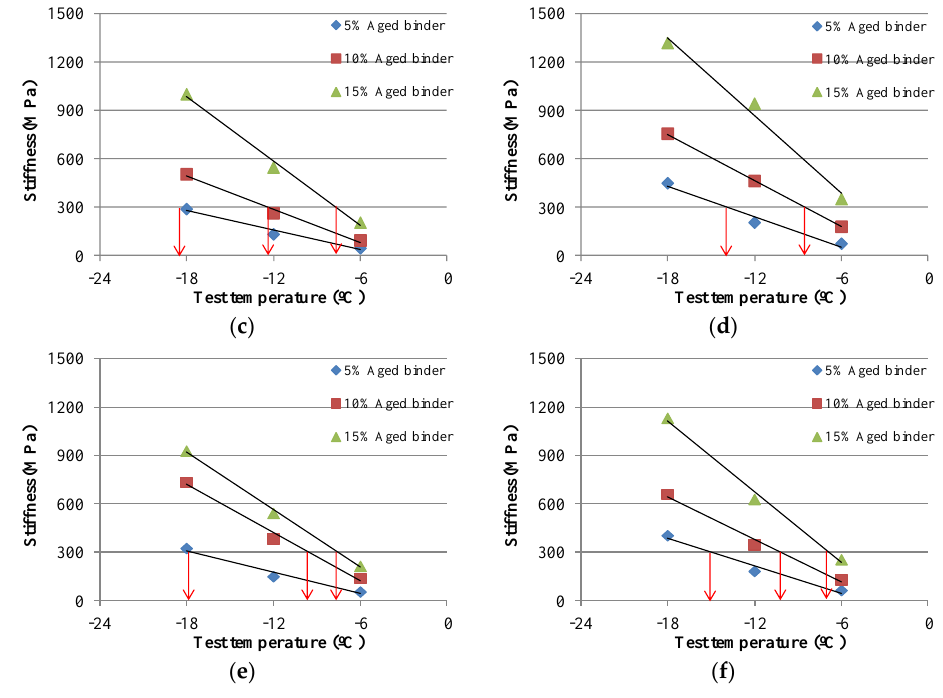
Figure 5. Low temperature determinations of RAP sources A–F with RTFO binder PG 58-22 in terms of stiffness, ( a – f ) RAP sources A–F.